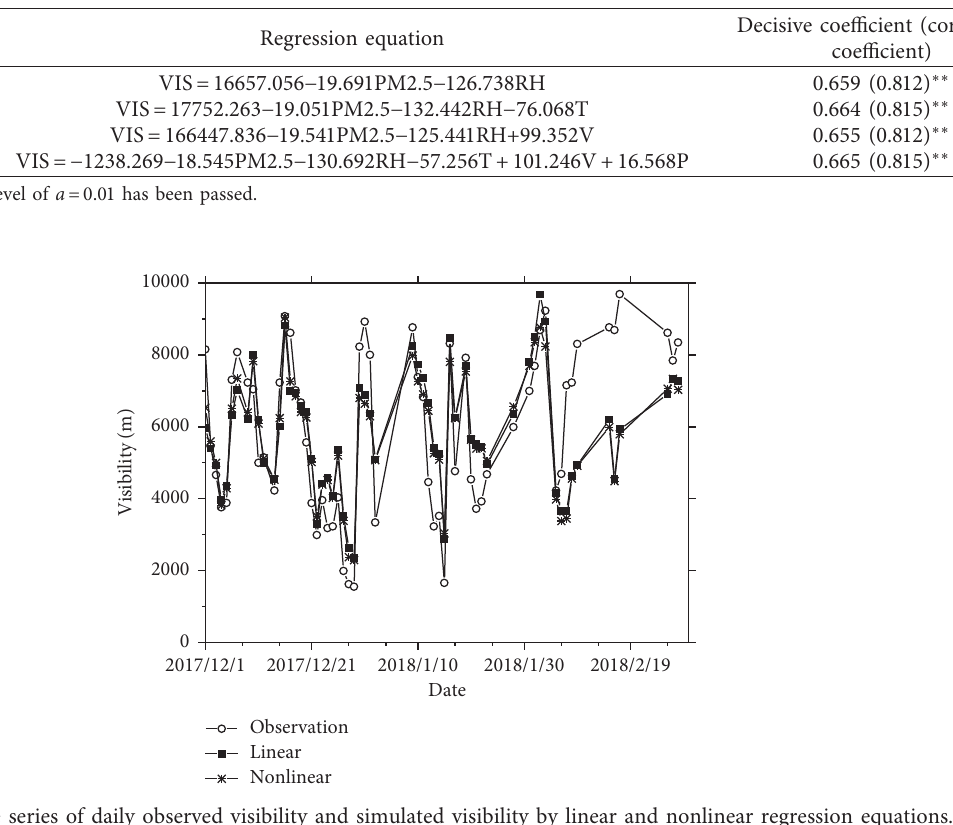
Table 3: Regression equations and R 2 (r) with different types of